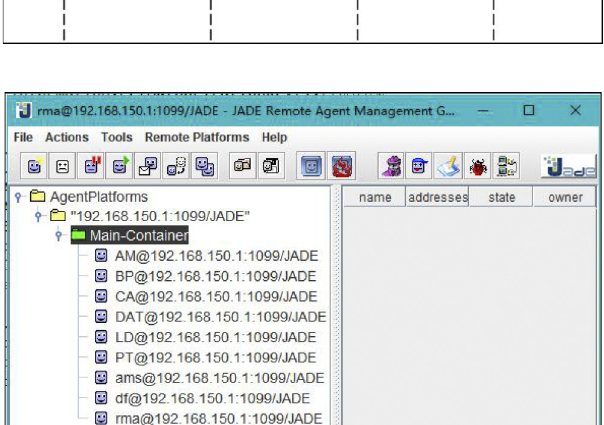
Figure 5. Time sequence of model update procedure